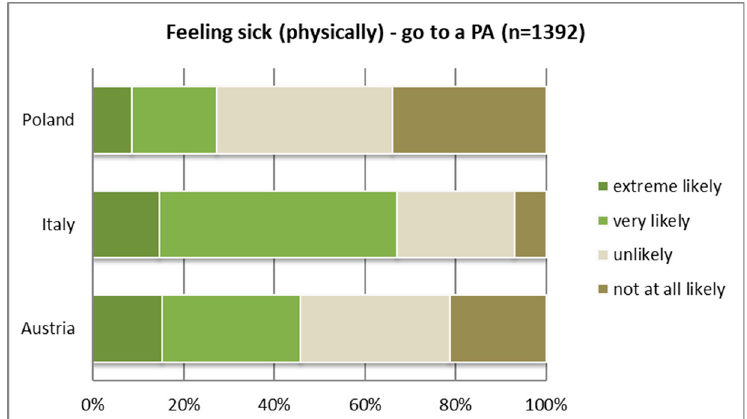
Figure 11. Likelihood of going to a protected area when feeling physically sick (in pain).